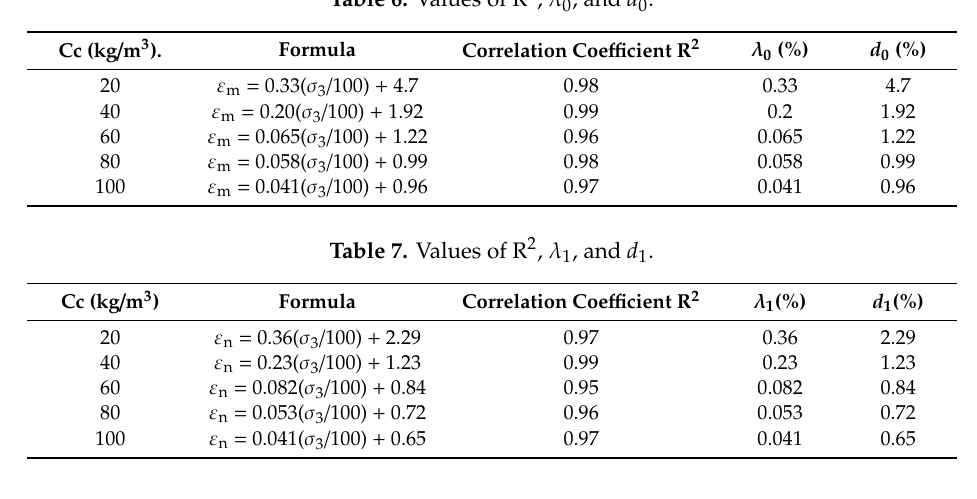
Figure 8. The relationship between the axial strain and confining pressure σ 3 : ( a ) the failure strain ε m ; ( b ) the axial strain at the initial dilatancy point ε n . Table 6. Values of R 2 , λ 0 , and d 0 .